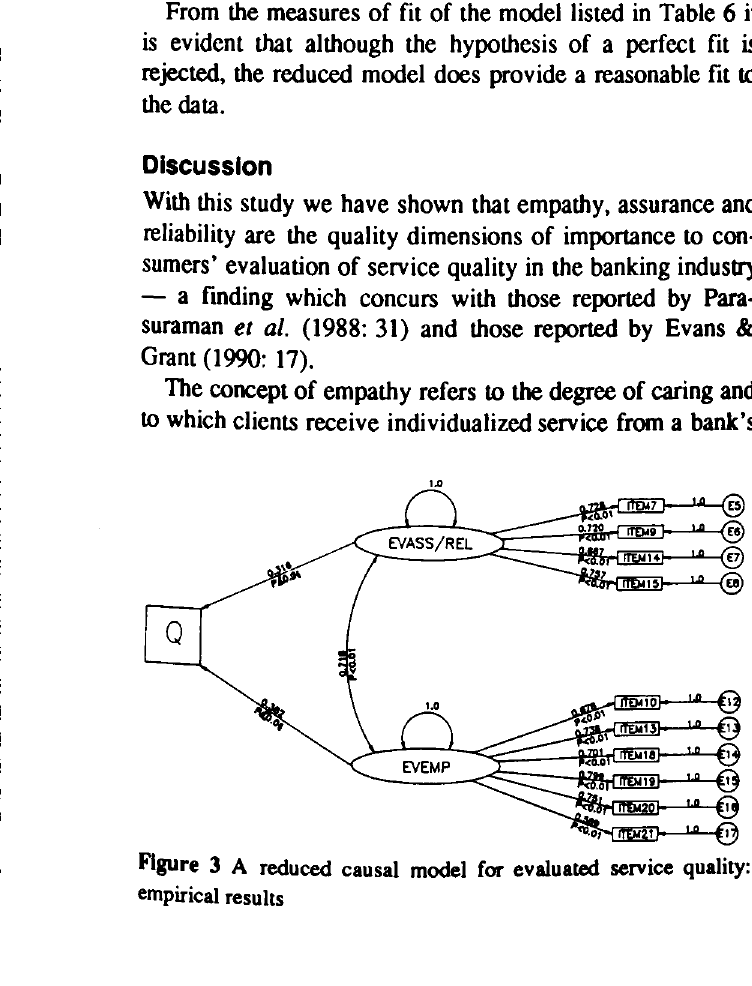
Figure 3 A reduced causal model for evaluated service quality: empirical results